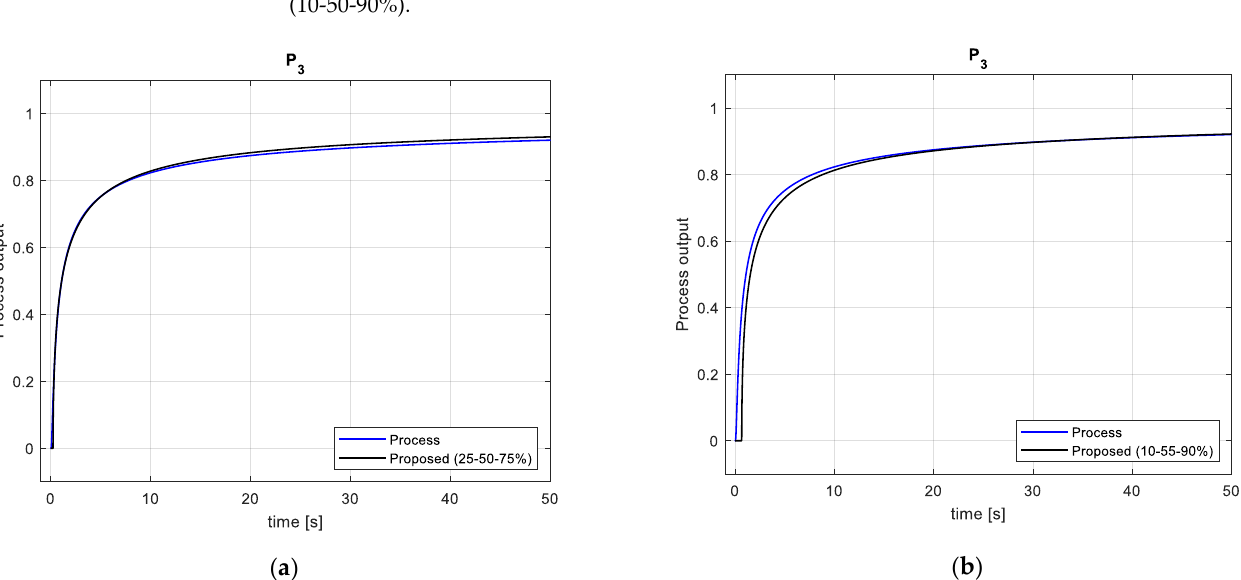
Figure 22. FFOPDT model step response using the proposed identification method for process P 3 and process reaction curve: ( a ) Symmetrical set of points (25-50-75%); ( b ) Asymmetrical set of points (10-55-90%).